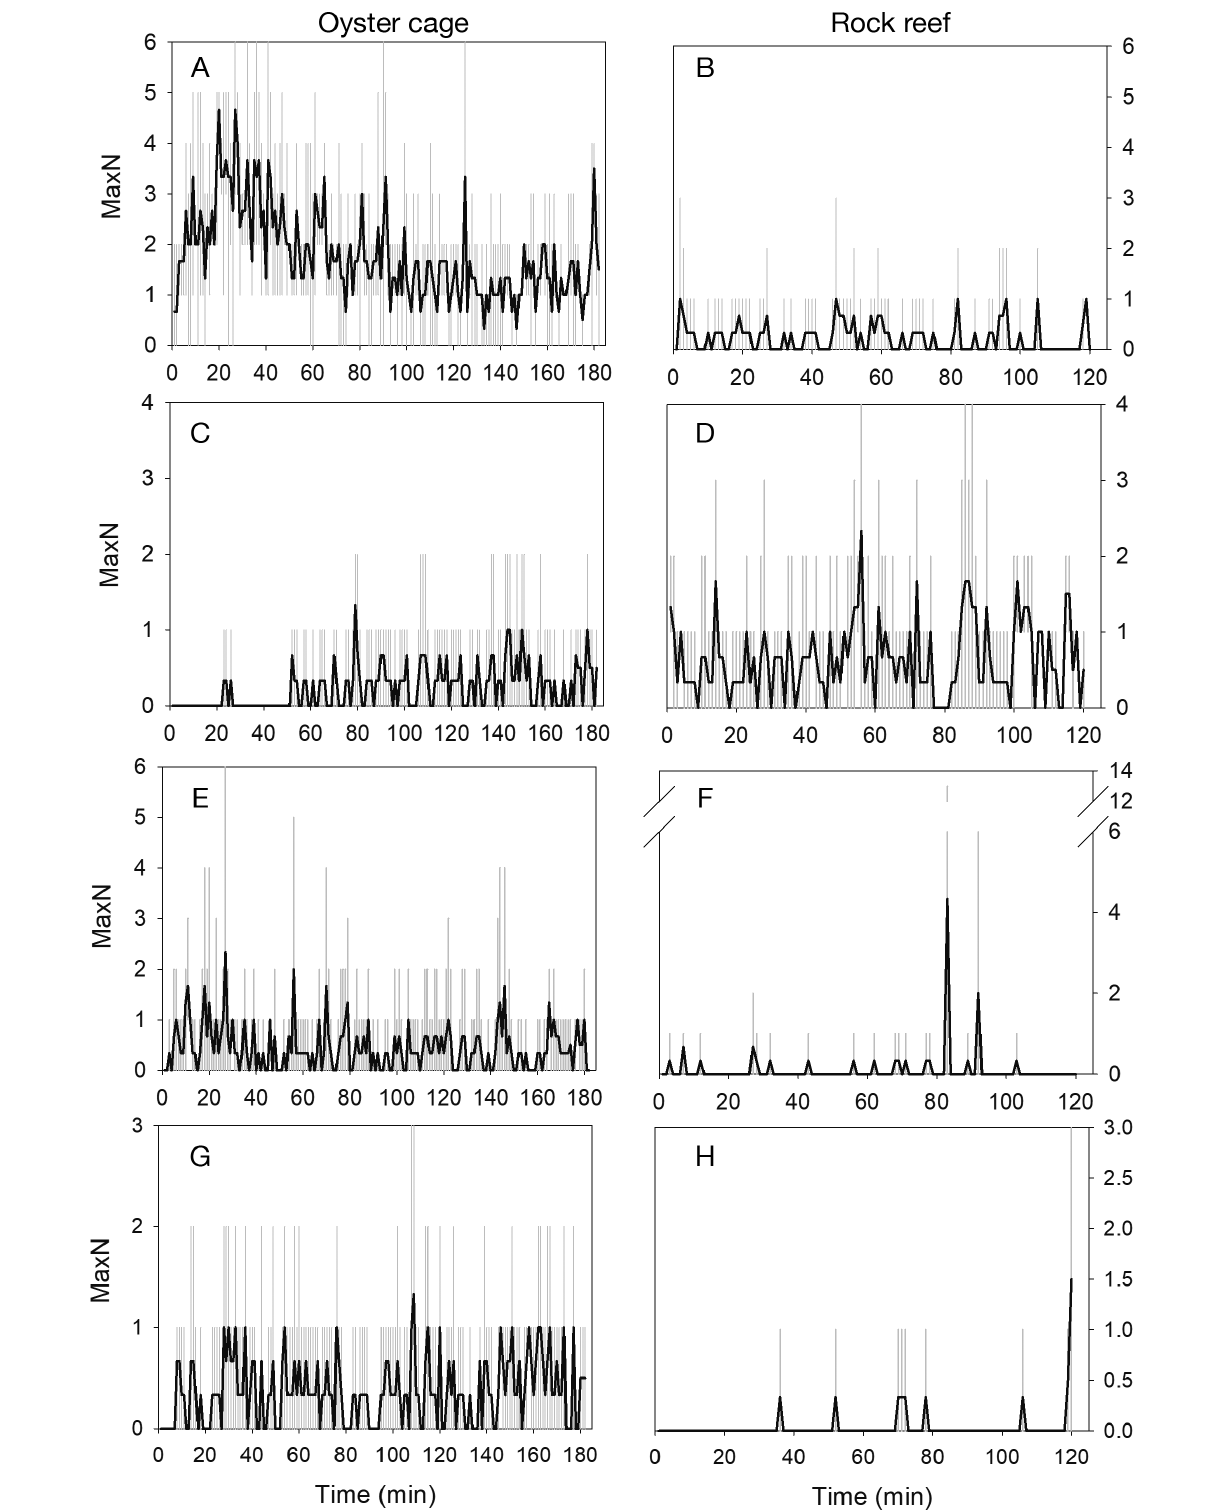
Fig. 5. Abundance of the 4 most common fish species observed during continuous video collection on 14 August 2017. Lines indicate mean of 3 replicates, gray bars represent min and max fish observed. (A,B) Black sea bass; (C,D) cunner; (E,F) scup; (G,H)